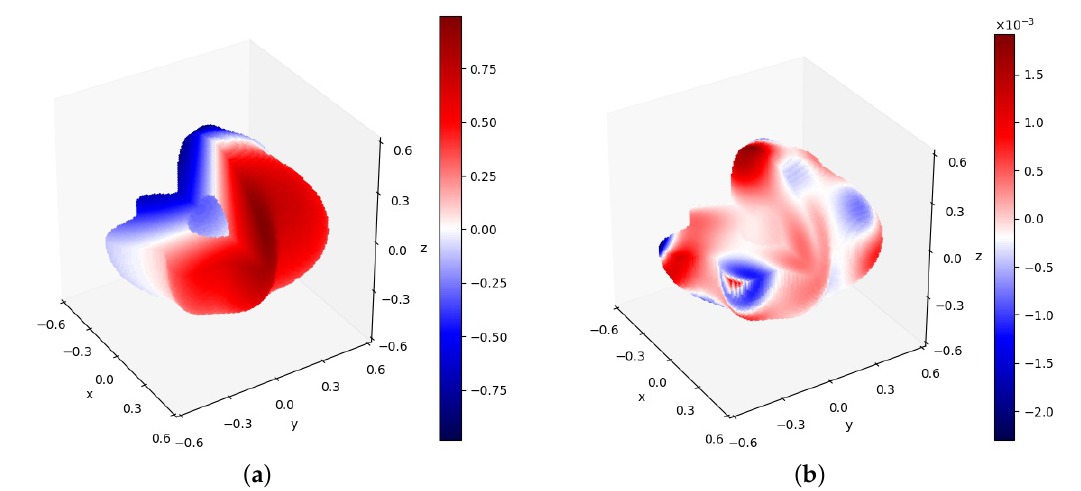
Figure 18. ( a ) The PINN solution and ( b ) the error between PINN and the exact solution for internal domain.